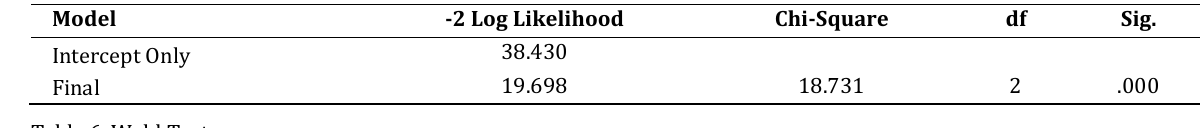
Table 6. Wald Test